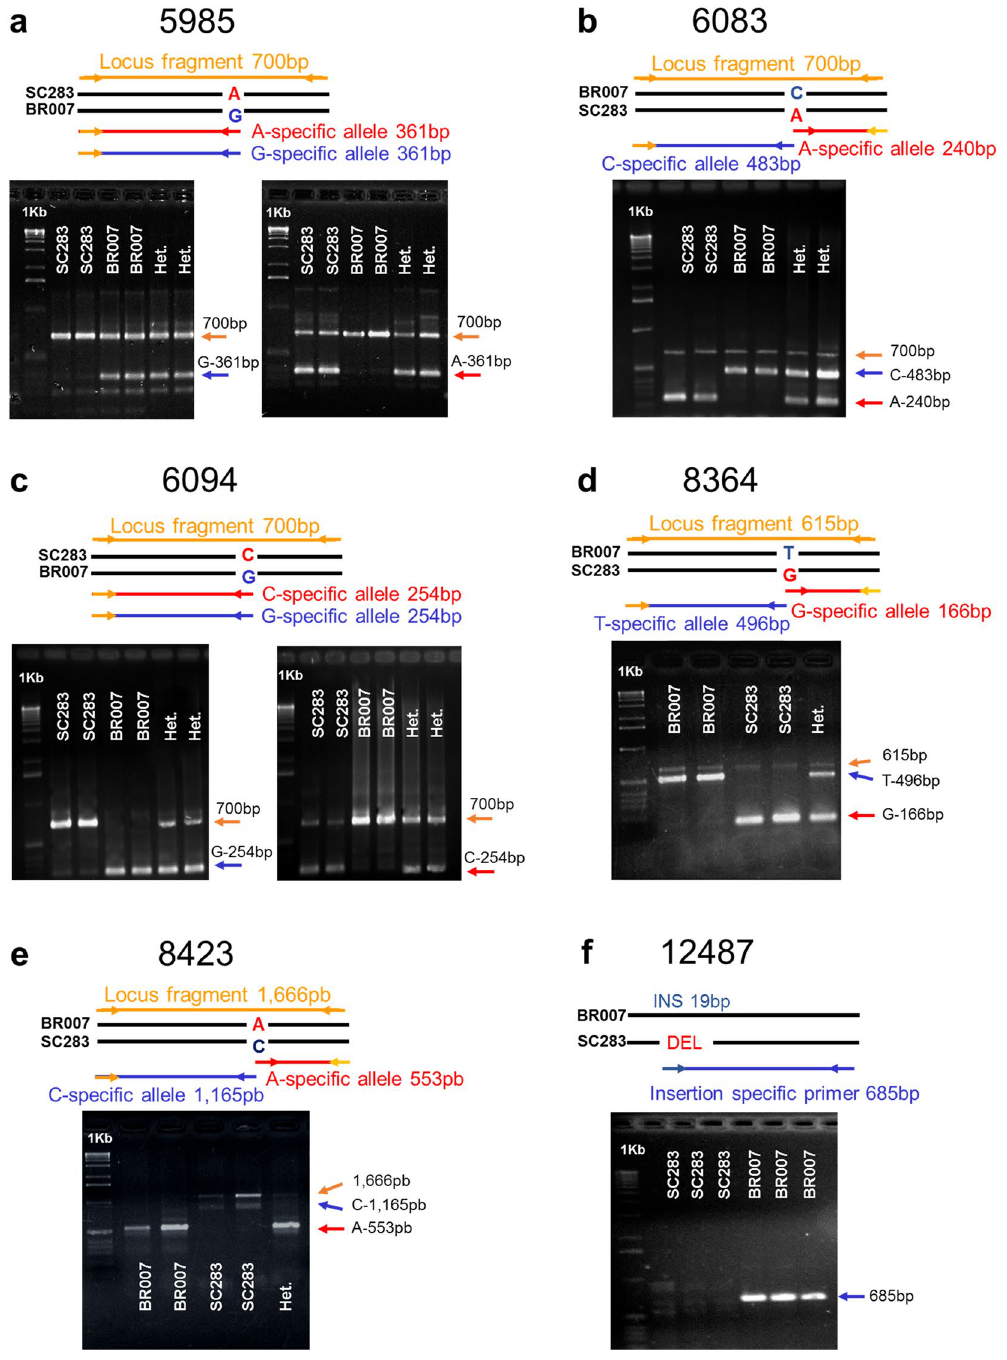
Figure 2. ARMS-PCR and Indel markers for Alt SB . Amplifications profiles are shown for two sorghum lines with different Alt SB haplotypes, SC283 (Al tolerant) and BR007 (Al sensitive) as well as for a heterozygous individual. A 1 Kb molecular-weight size marker was loaded in the first well. The PCR products were resolved in 1.5% agarose gel. The amplification profiles of dominant ( a , c ), co-dominant ( b , d , e ) and the dominant indel ( f ) marker systems are shown. We are showing cropped gel images, which are presented either individually for each co-dominant marker ( b , d , e ) and for the indel marker ( f ) or separated by blank spaces in the case of each of the two alleles revealed by each dominant marker system ( a , c